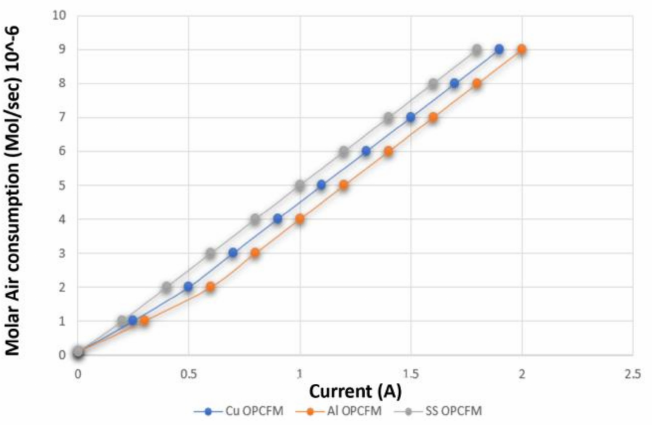
Figure 17. Air consumption for Al, Cu and SS OPCFM flow plate